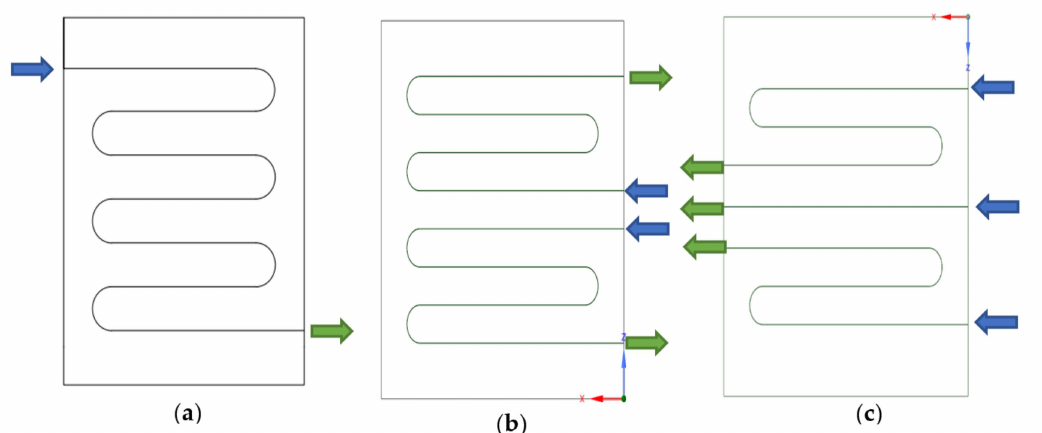
Figure 1. Flow configurations: ( a ) one-inlet-one-outlet serpentine, ( b ) counterflow two-inlet-two-outlet serpentine, ( c ) three-inlet-three-outlet serpentine configurations. Note: inlet (blue arrow) and outlet (green